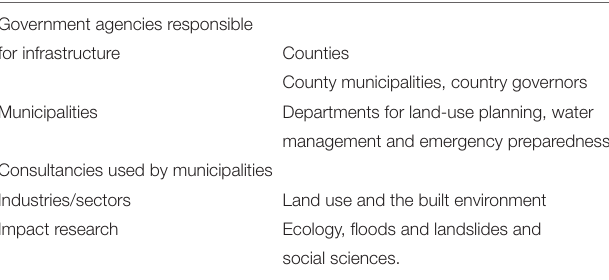
TABLE 1 | Prioritized user